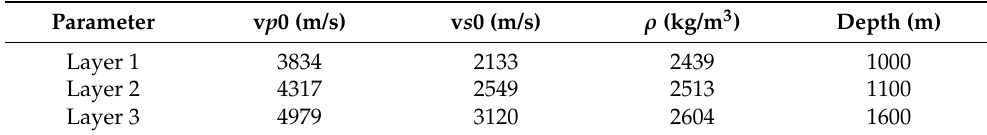
Table 1. The 1-D velocity model used in the forward models.